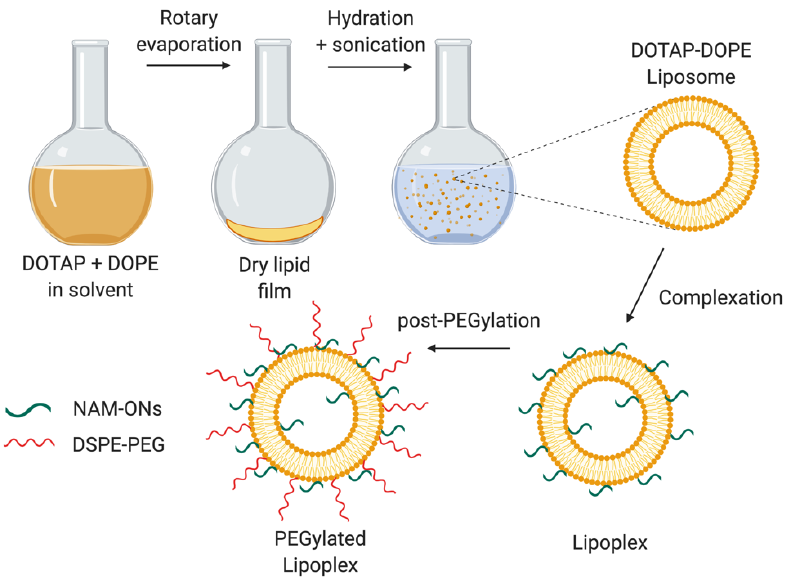
Figure 1. Schematic representation of the preparation of the PEGylated DOTAP–DOPE liposomes and lipoplexes. The liposomes, resulting from the hydration of a lipid film composed of DOTAP and DOPE, were incubated with the negatively charged HiLyte 488 labeled ONs to form lipoplexes. The post-PEGylation was achieved by adding DSPE-PEG at a final concentration of 10%. Created using BioRender.com. (Accessed on 1 June 2021).